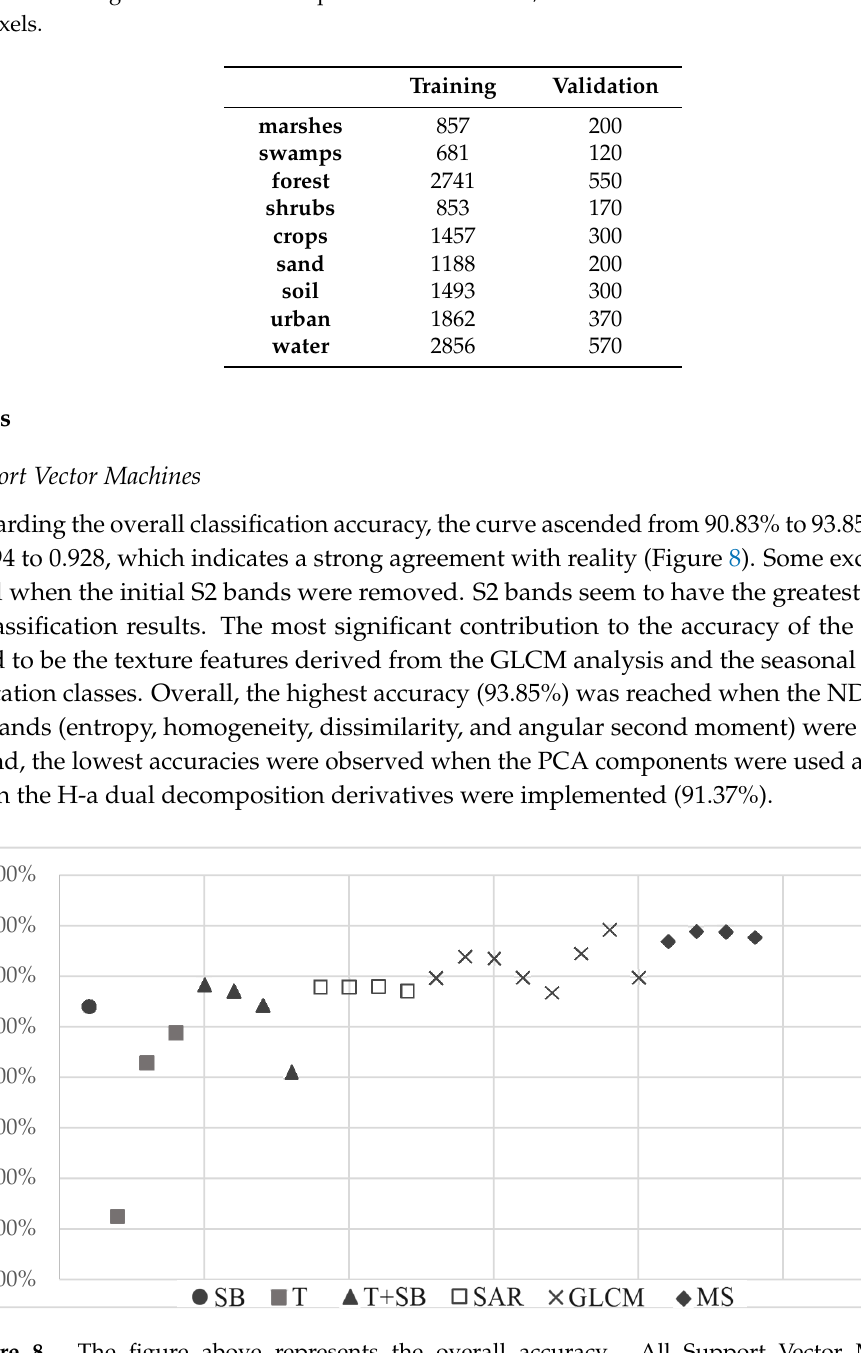
Figure 8. The figure above represents the overall accuracy. All Support Vector Machines (SVM)-based classifications were grouped into six groups according to the legend: SB, Spectral Bands; T, Transformations; MS, Multi Seasonal; GLCM, Texture Analysis and SAR, Synthetic Aperture Radar (as also shown in Table 4).